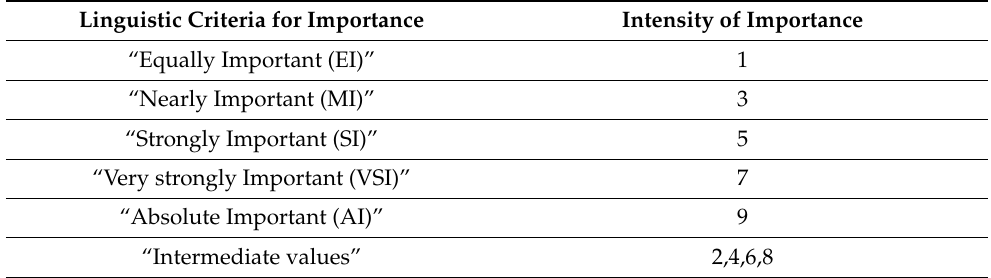
Table 6. Scale for AHP